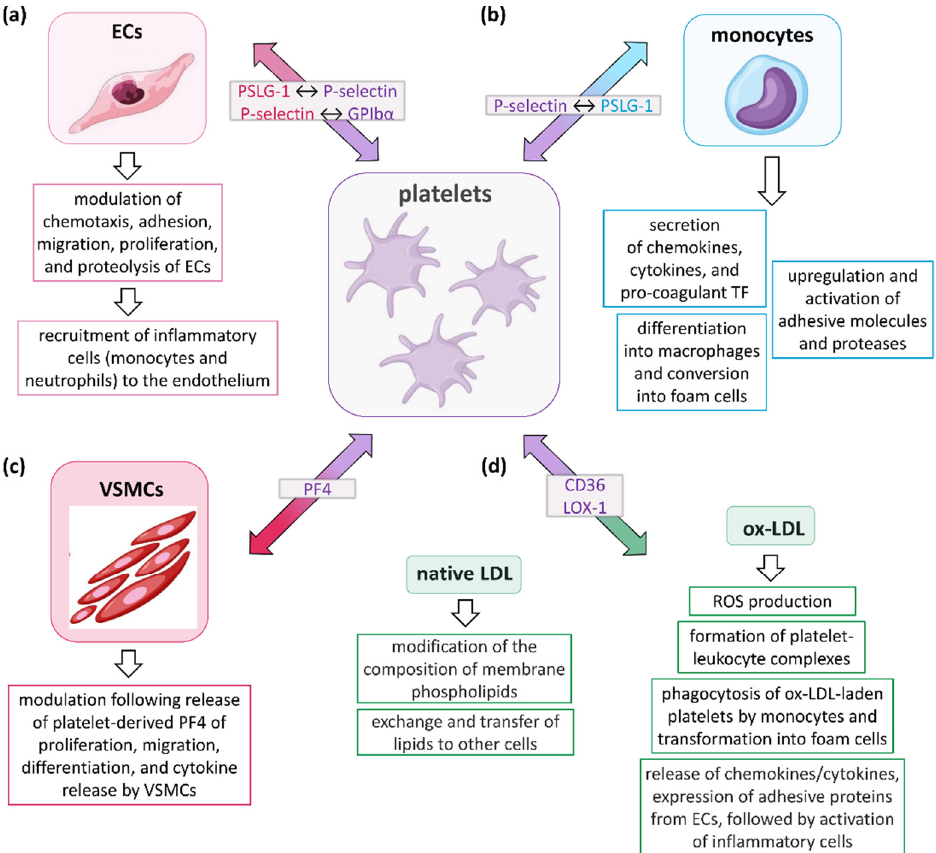
Figure 1. Role of platelets in the development and progression of AS. Platelets influence the atherosclerotic process by communicating with ( a ) endothelial cells (ECs), ( b ) leukocytes (mainly monocytes, but also neutrophils, T lymphocytes, and dendritic cells), ( c ) vascular smooth muscle cells (VSMCs), and ( d ) low-density lipoprotein (LDL), either in the native or oxidized form (ox-LDL). Collectively, these interactions induce platelets to release a variety of inflammatory mediators capable of affecting several biological functions of their target cells, including secretion, adhesion, migration, recruitment of other cell types, proteolysis, and coagulation. In the light grey boxes, the molecules participating in initial interactions between cells are indicated, with the colors representing the cells in which they are expressed. PSLG-1, P-selectin glycoprotein ligand-1; GPIb α , glycoprotein Ib α ; TF, tissue factor; PF4, platelet factor 4 (or CXCL-4); LOX-1, low-density lipoprotein receptor-1; ROS, reactive oxygen